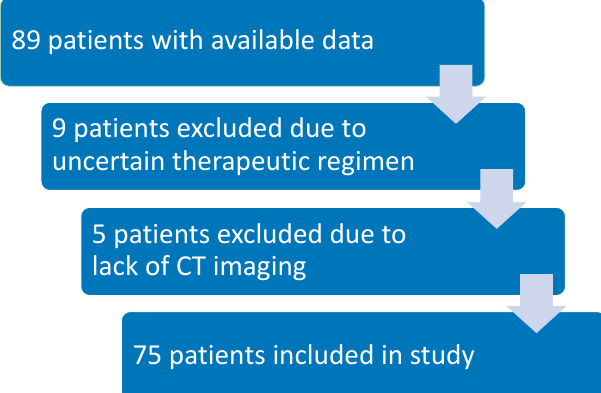
Figure 1. Patient selection.